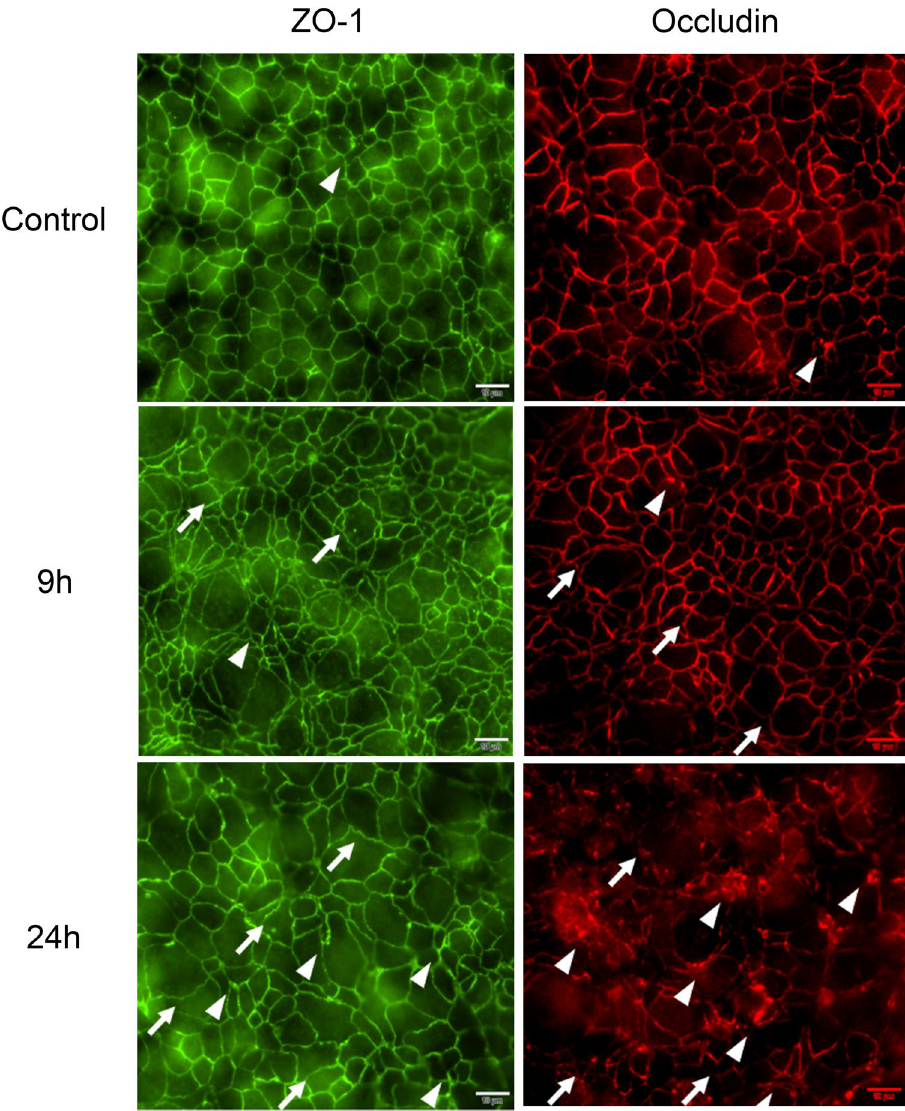
point. Aggregates of ZO-1 and Occludin (arrowheads) suggest an internalization of tight junctions. Uneven pulling of the cytoskeleton on the tight junctional network is observed as sinusoidal irregularities (arrows). Occludin pseudo-colored red for clarity. Scale bar 20